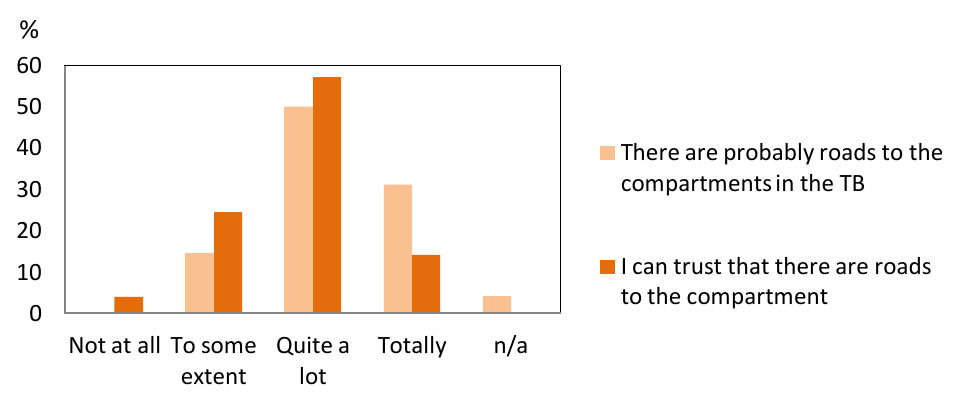
Figure 6. Harvest managers’ faith in the TB’s information about the roads within